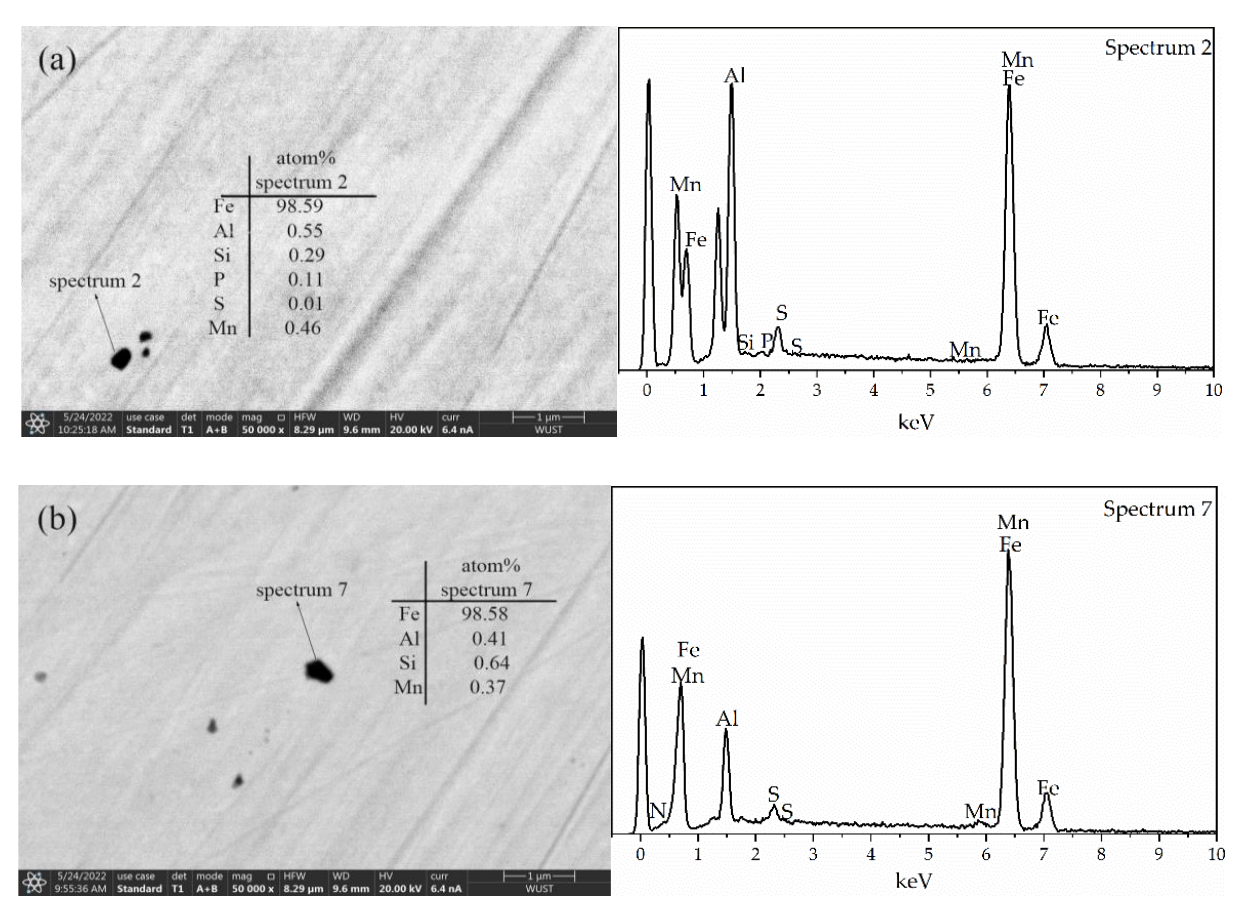
Figure 1. Results of typical precipitates from FE-SEM/EDS analysis in experimental steel: ( a ) (Al,Si,Mn) x N y -P; ( b ) (Al,Si,Mn) x N y. Figure 2 indicates the correlation of the number density and average size of precipitates in the samples with the increase of the target phosphorus content. The number density and the average size of the precipitates increased initially as the target phosphorus content in the steel increased, and then, the lowest number density and the largest average size of the precipitates appeared in the 0.14%P-targeted sample. The average size of the main precipitates in the samples is shown in Figure 3. Figure 4 is the percentage of the number density of precipitates of different sizes of the total precipitates with different P-targeted samples. Combined with the results listed in Table 1, when the target phosphorus content increased, the number density of (Al,Si,Mn) x N y in the steel decreased, and the number density of the P-containing precipitates (Al,Si,Mn) x N y -P and (Al,Si,Mn) x N y -MnS-P tended to increase. The average size of the precipitates decreased when the target phosphorus content increased to 0.18%. This was related to the removal or coarsening of the precipitates after phosphorus increased in the steel. Compared with the 0.14%P-targeted sample, only a small number density increase of the precipitates appeared in the 0.18%P-targeted sample, which indicates more P addition exceeding 0.14% has little effect on the precipitation of fine P-bearing precipitates within the statistical error. However, adding another point beyond 0.14%P would make the results more reliable, and the experimental results were more detailed to certify the effect of P in the